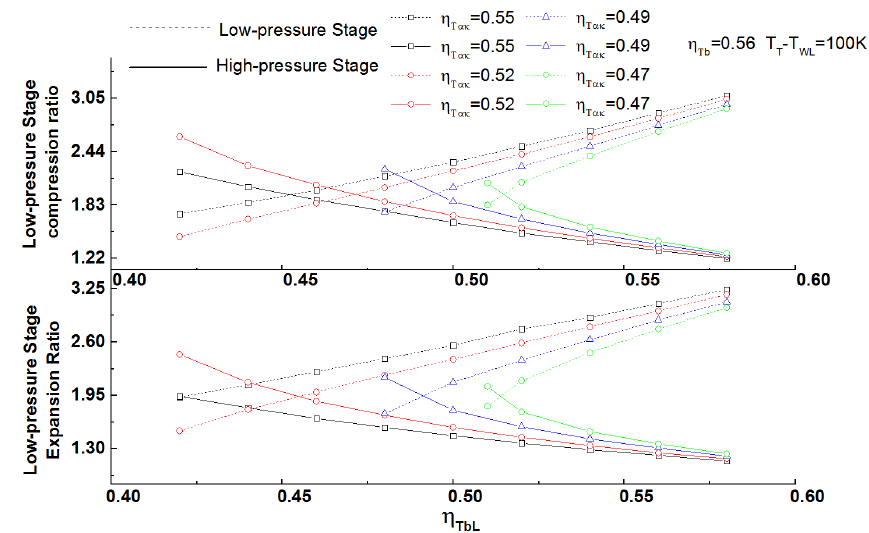
Figure 4. E ff ect of low-pressure stage turbocharger e ffi ciency on two-stage pressure ratio and Figure 4. Effect of low-pressure stage turbocharger efficiency on two-stage pressure ratio and expansion Ratio. expansion Ratio.